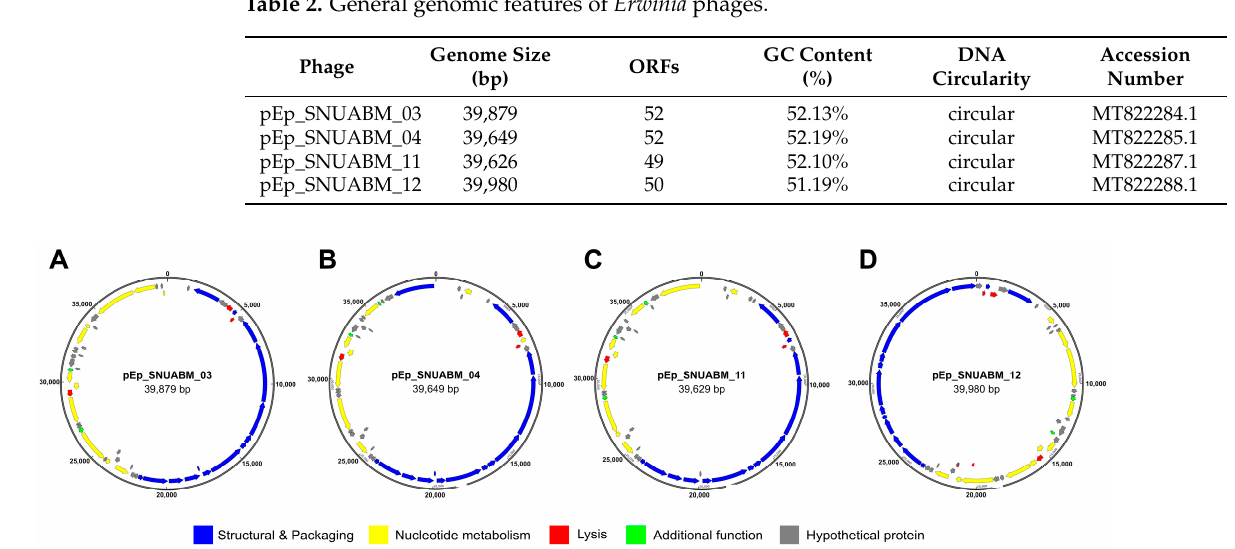
Figure Figure 4. Genome map of Erwinia phages (A) pEp_SNUABM_03, (B) pEp_SNUABM_04, (C) pEp_SNUABM_ 11, and (D) pEp_SNUABM_12 The color-coded ORFs are classified based on their function (Scale = base pair). Table 2. General genomic features of Erwinia phages.